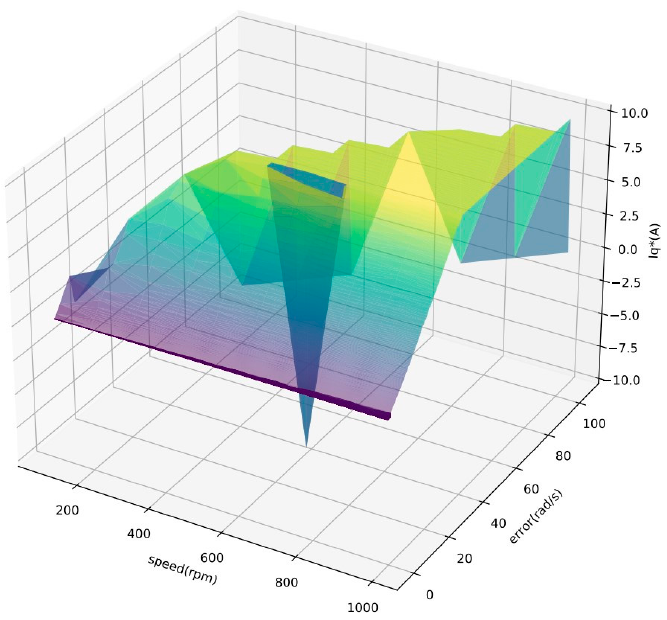
Figure 3. The reference current q ‐ axes with different speed references and speed errors.